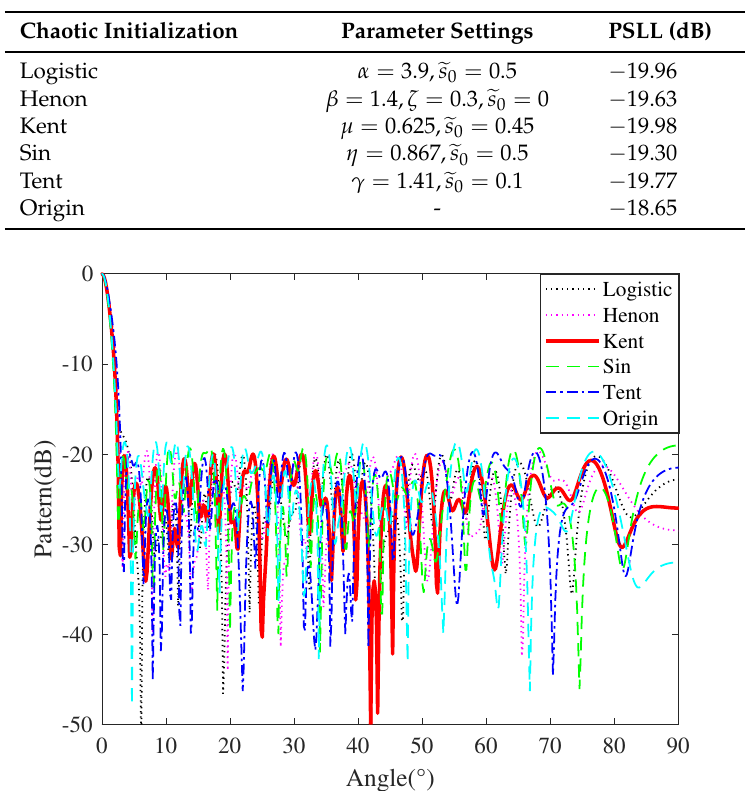
Table 2. PSLLs and the numbers of iterations for five chaotic initialization methods.